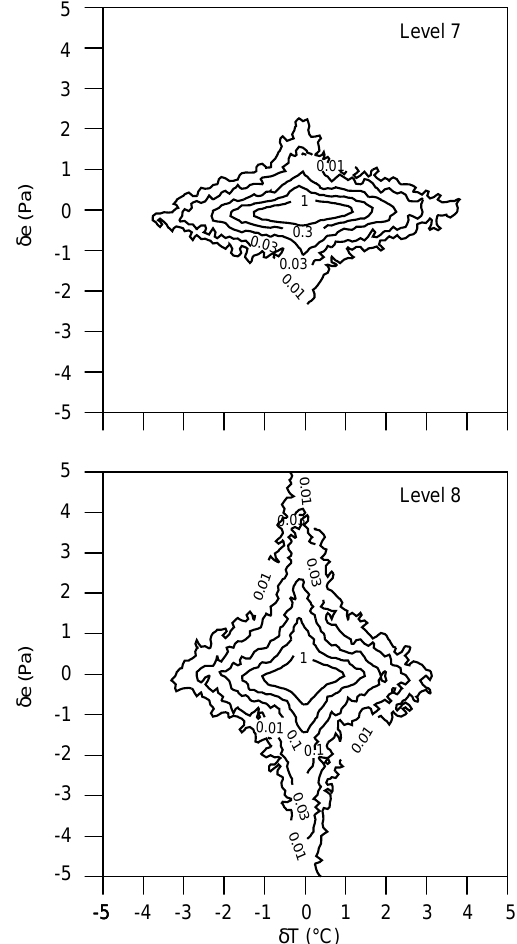
Fig. 9. Relative frequency of common fluctuations of water vapour partial pressure, (cid:100) e , and temperature, (cid:100) T based on the MOZAIC data bank. The horizontal ‘‘axis’’ of the frequency distribution is slightly tilted which means a weak positive correlation between (cid:100) e and (cid:100)